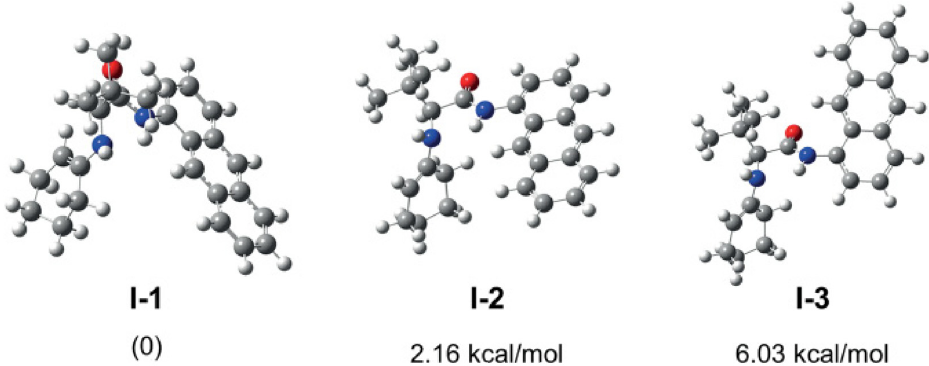
Figure 2. Structures and relative energies of intermediates I - 1 – 3 calculated at the B3LYP/6- 311++G(d,2p)//B3LYP/6-31+G(d) levels of theory. Energy values are compared to the lowest-energy isomer I - 1 . Reprinted with permission from Ref. [69]. Copyright 2016, John Wiley and Sons.